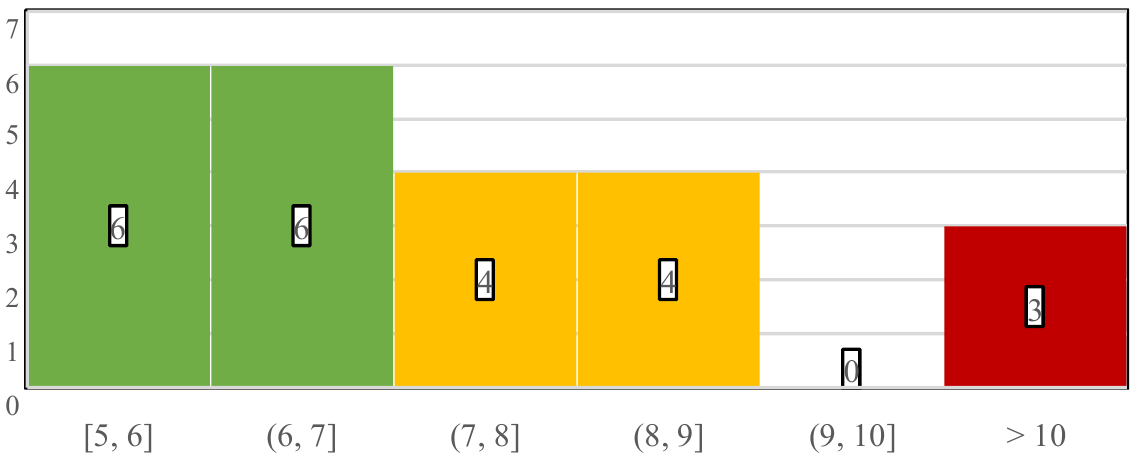
Figure 6. Numbers below the histogram indicate the time interval in days that was necessary for wound closure, while numbers in the bars indicate the number of patients who healed in the corre- sponding interims.